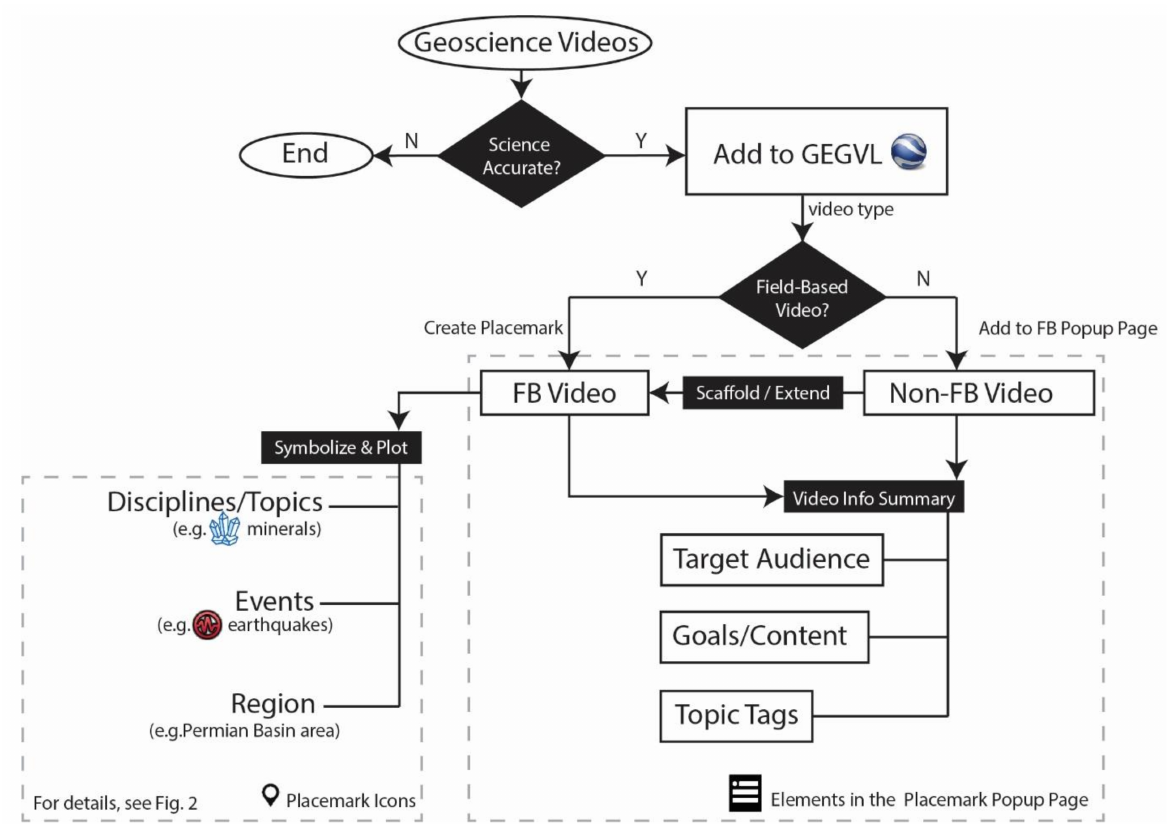
Figure 1. Framework of the Google Earth Geoscience Video